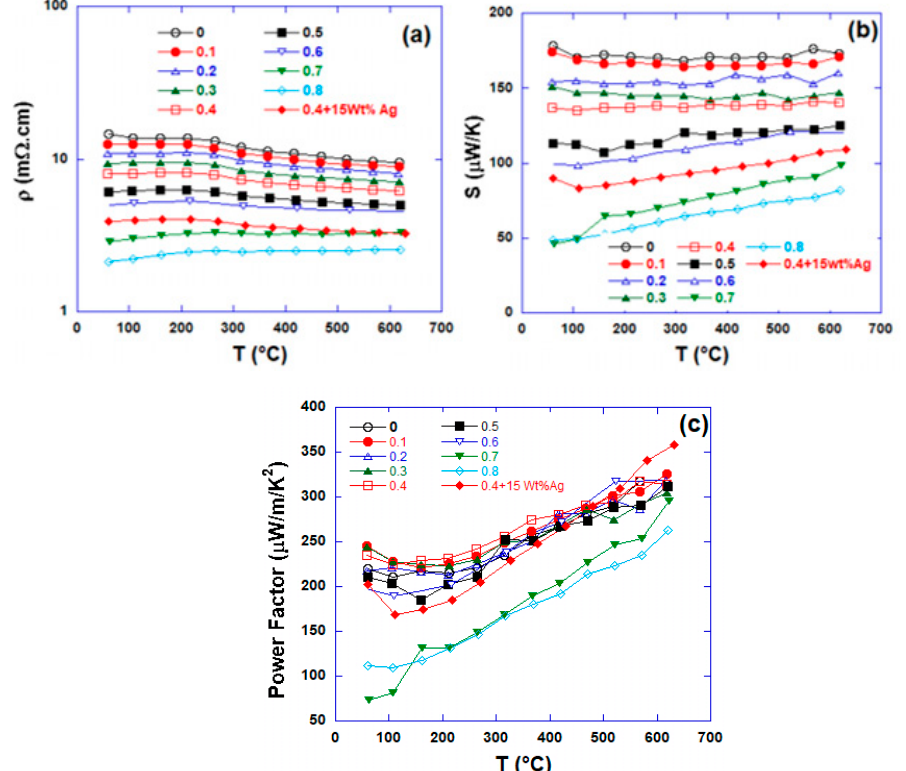
Figure 6. Temperature dependence of thermoelectric properties ( a ) electrical resistivity, ( b ) See- coefficient and ( c ) Power factor of Ca 3-x Ag x Co 4 O 9 /Ag beck coefficient and ( c ) Power factor of Ca 3-x Ag x Co 4 O 9 /Ag composites.